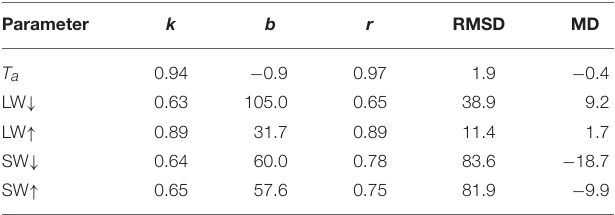
Frontiers in Earth Science |